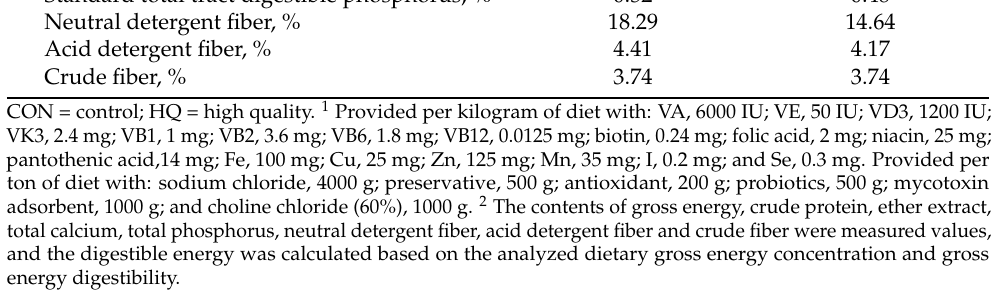
Table 1. Cont. Items CON HQ Total phosphorus, % 0.80 0.96 Standard total tract digestible phosphorus, % 0.32 0.48 Neutral detergent fiber, % 18.29 14.64 Acid detergent fiber, % 4.41 4.17 Crude fiber, % 3.74